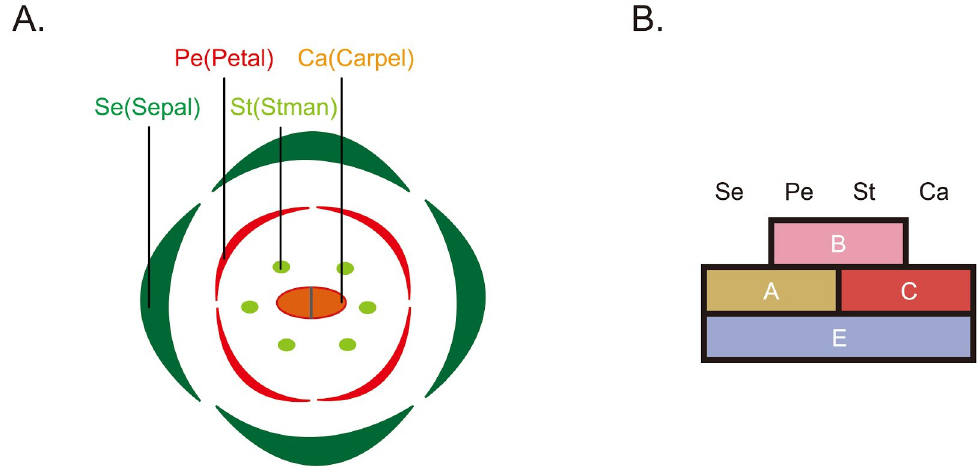
Fig 1. Top-down view of a flower and ABCDE model. Diagram A. top-down view of a flower. Se, sepal (green); pe, petal (red); st, stamen (green); ca, carpel (orange). Diagram B. A schematic of general flowers with four floral organs arranged in four floral whorls. The ABCDE model encompasses the original ABC model, which proposes that the A, B, and C genes function together to elaborate the different floral organs. Additionally, the ABCDE model proposes that E function is necessary to the formation of all organ types